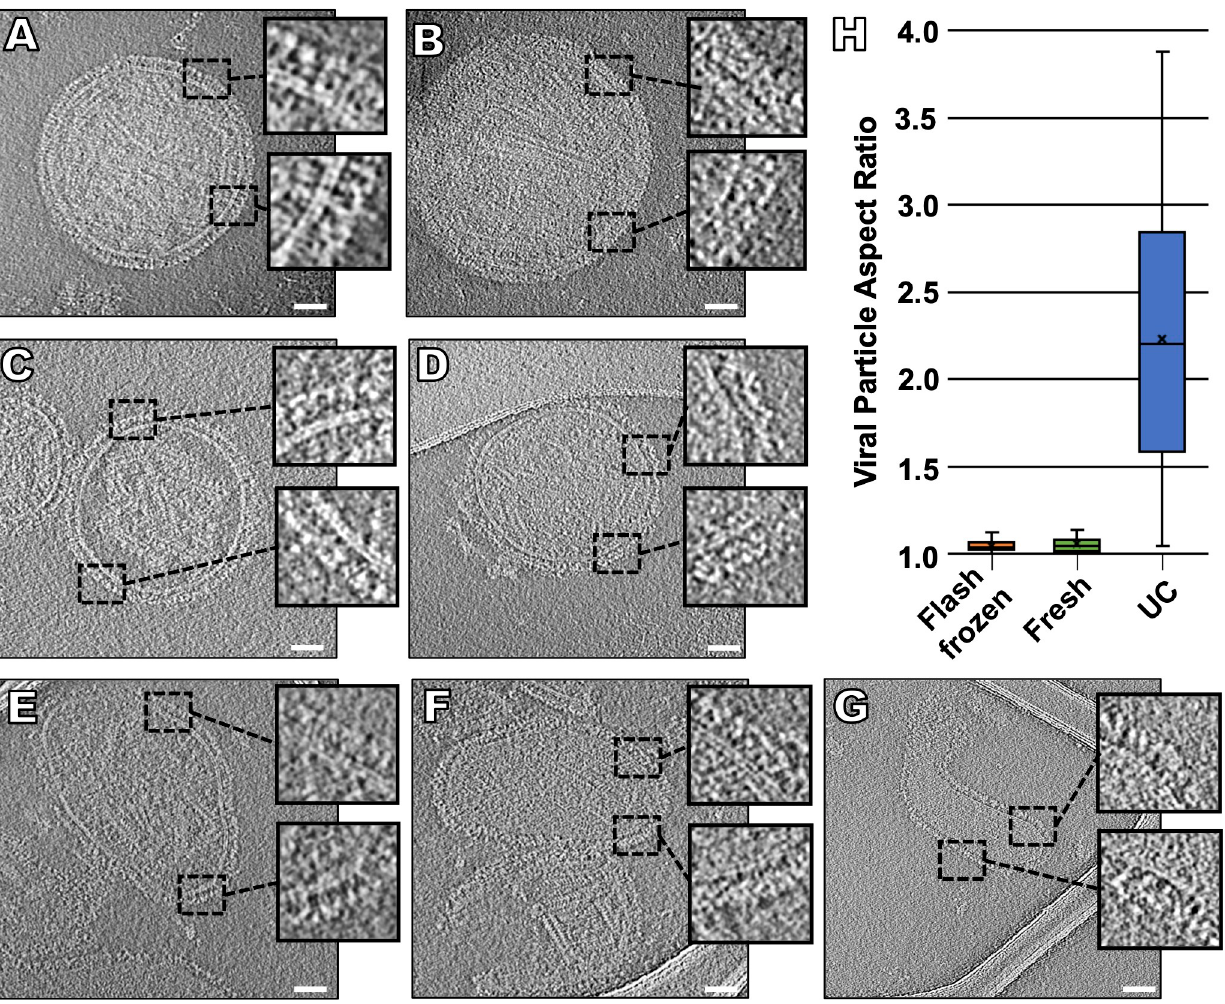
Fig 1. Changes in viral morphology resulting from different purification methods. Contrast inverted cryo-ET central slices of clarified supernant fluid collected directly from infected Vero cells and either imaged after being flash frozen ( A, B ), fresh ( C, D ), or ultracentrifuged ( E-G ). Inserts represent enlarged regions of the viral glycoprotein layer. ( H ) Viral particle aspect ratio of all three purification methods (n = 50). Scale bars: ( A-G ) 50 nm.